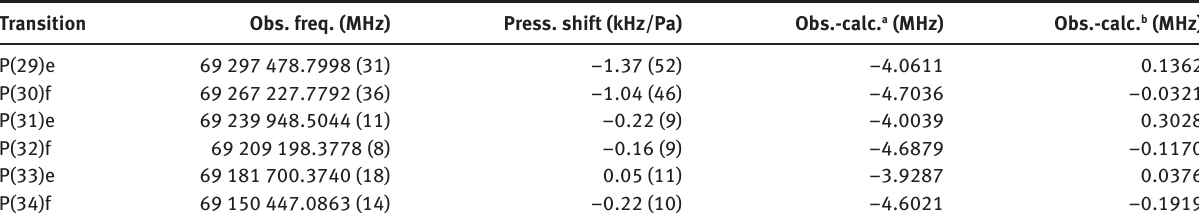
Table 2: Observed line-center frequencies and self-pressure shift coefficients for six transitions belonging to the (01 1 1 − 01 1 0) ro-vibrational band of 12 C 16 O 2